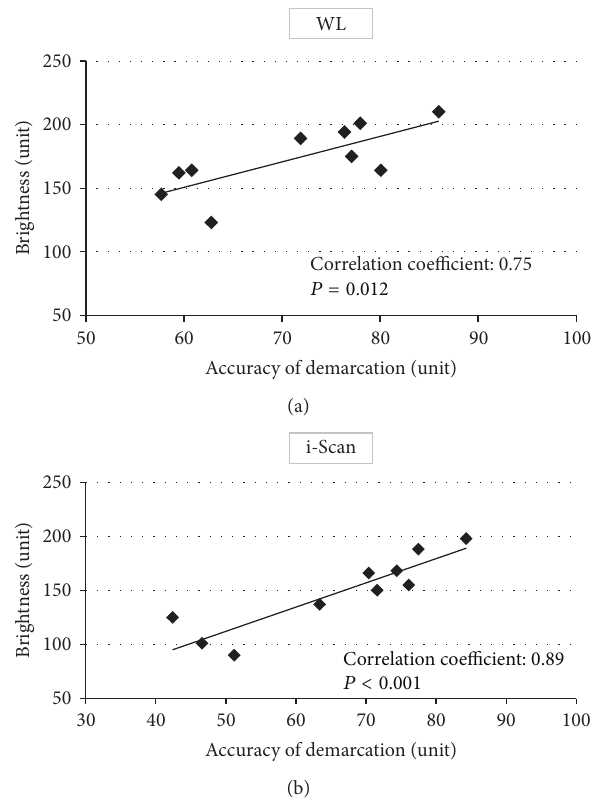
Figure 5: Correlation between accuracy of demarcation and lesion brightness. Correlation coefficients were 0.75 ( 𝑃 = 0.012 ) for white light (WL) (a) and 0.89 ( 𝑃 < 0.001 ) for i-Scan (b)